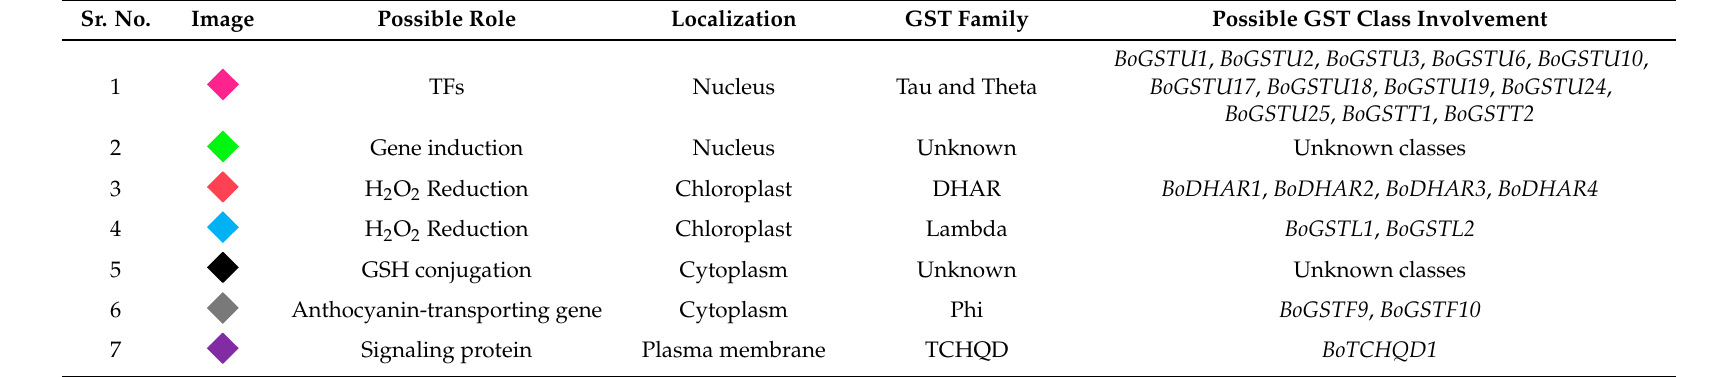
Table 4. Predicted BoGST genes involving in various pathways during cold stress in B. oleracea . Sr. No.